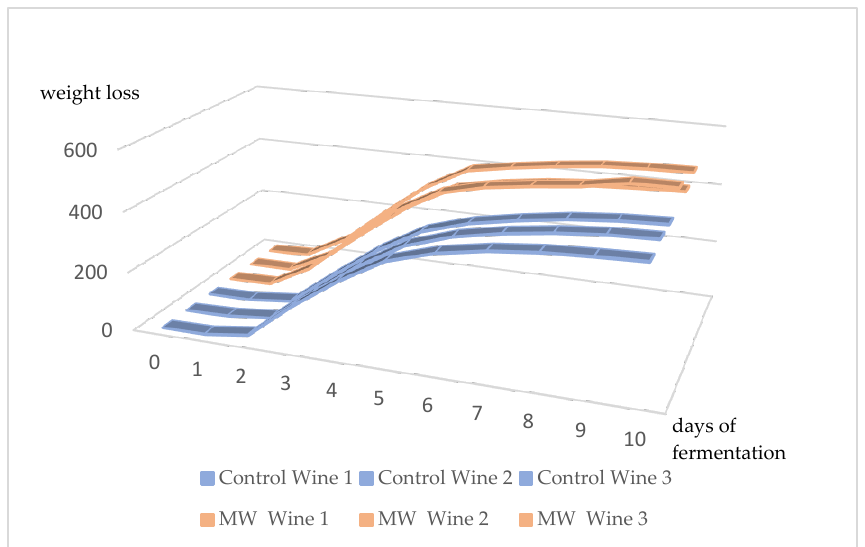
Figure 2. Alcoholic fermentation kinetics measured by the weight loss in control wines and wines from microwave treatment (triplicates of fermentation are shown).